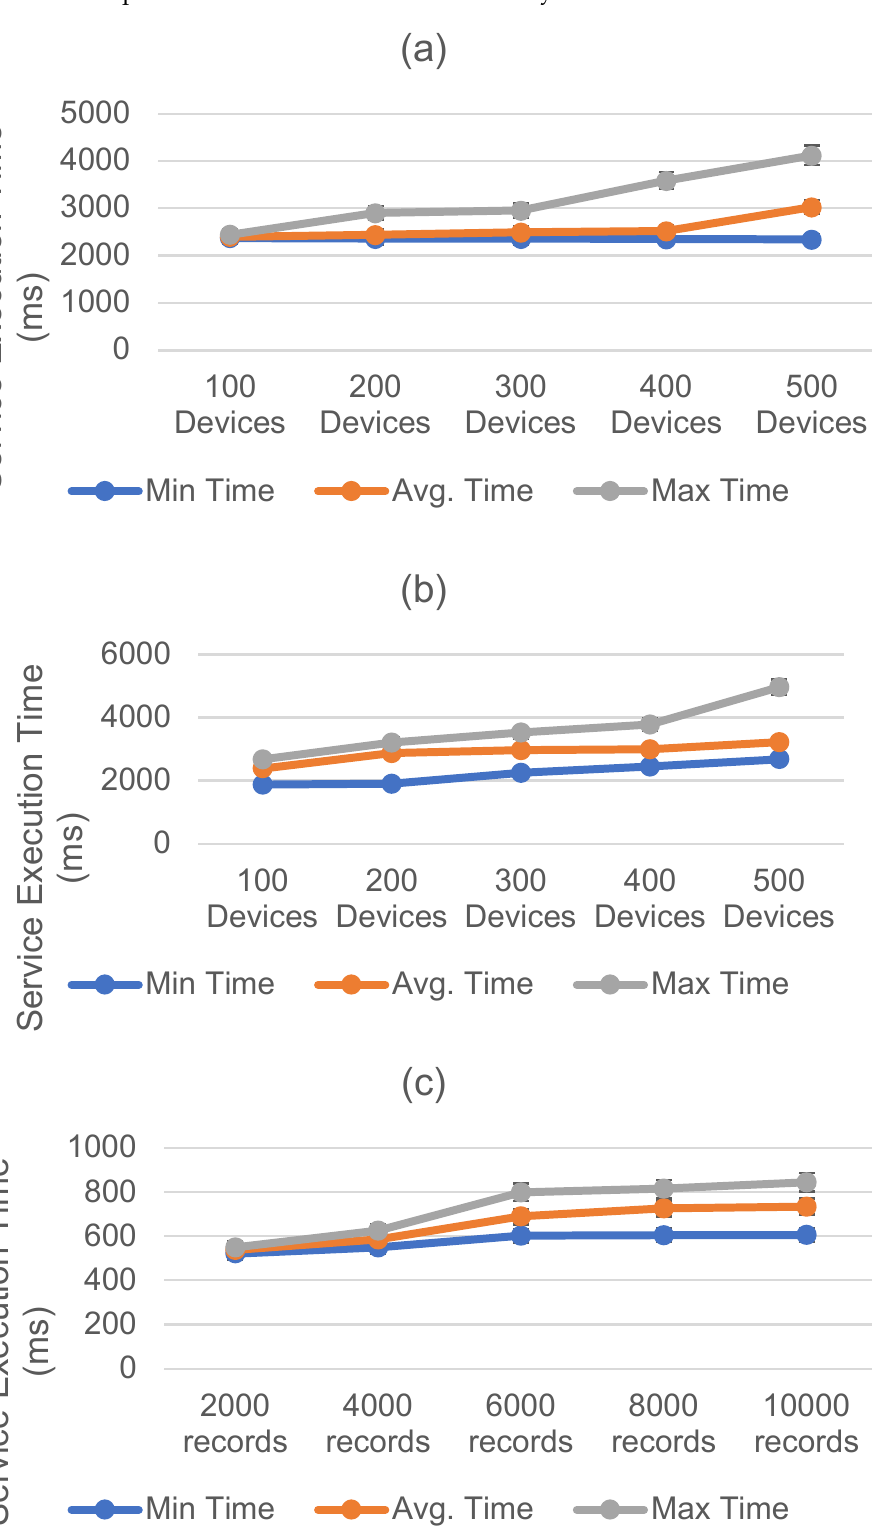
Figure 8. Performance evaluation for electricity department: ( a ) performance evaluation for device creation; ( b ) performance evaluation for sensor reading; ( c ) performance evaluation for query pro- cessing.